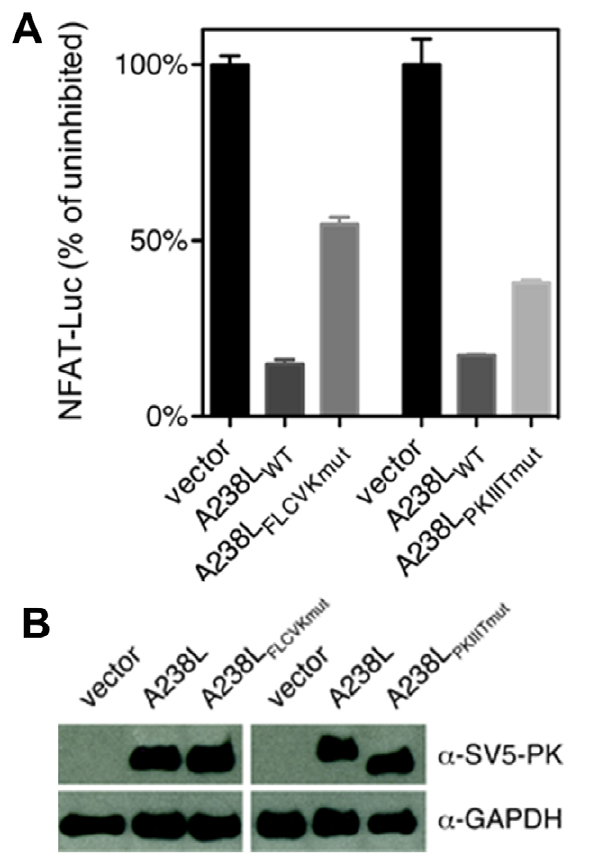
Figure 5. A238L inhibits CN by interfering with substrate docking. (A) NFAT-dependent transcription was measured in stimu- lated HEK293T cells co-transfected with an NFAT-luciferase reporter plasmid and a plasmid expressing SV5-PK-tagged A238L wild-type or motif mutant proteins, or vector alone. Data are means 6 s.e.m. from three independent experiments. (B) Transiently transfected SV5-PK- tagged A238L protein expression levels were analyzed by immuno- blotting. The increased electrophoretic mobility of A238L PKIIITmut relative to wt-A238L may be due to changes in a posttranslational modification that is known to affect the electrophoretic mobility of A238L [55].